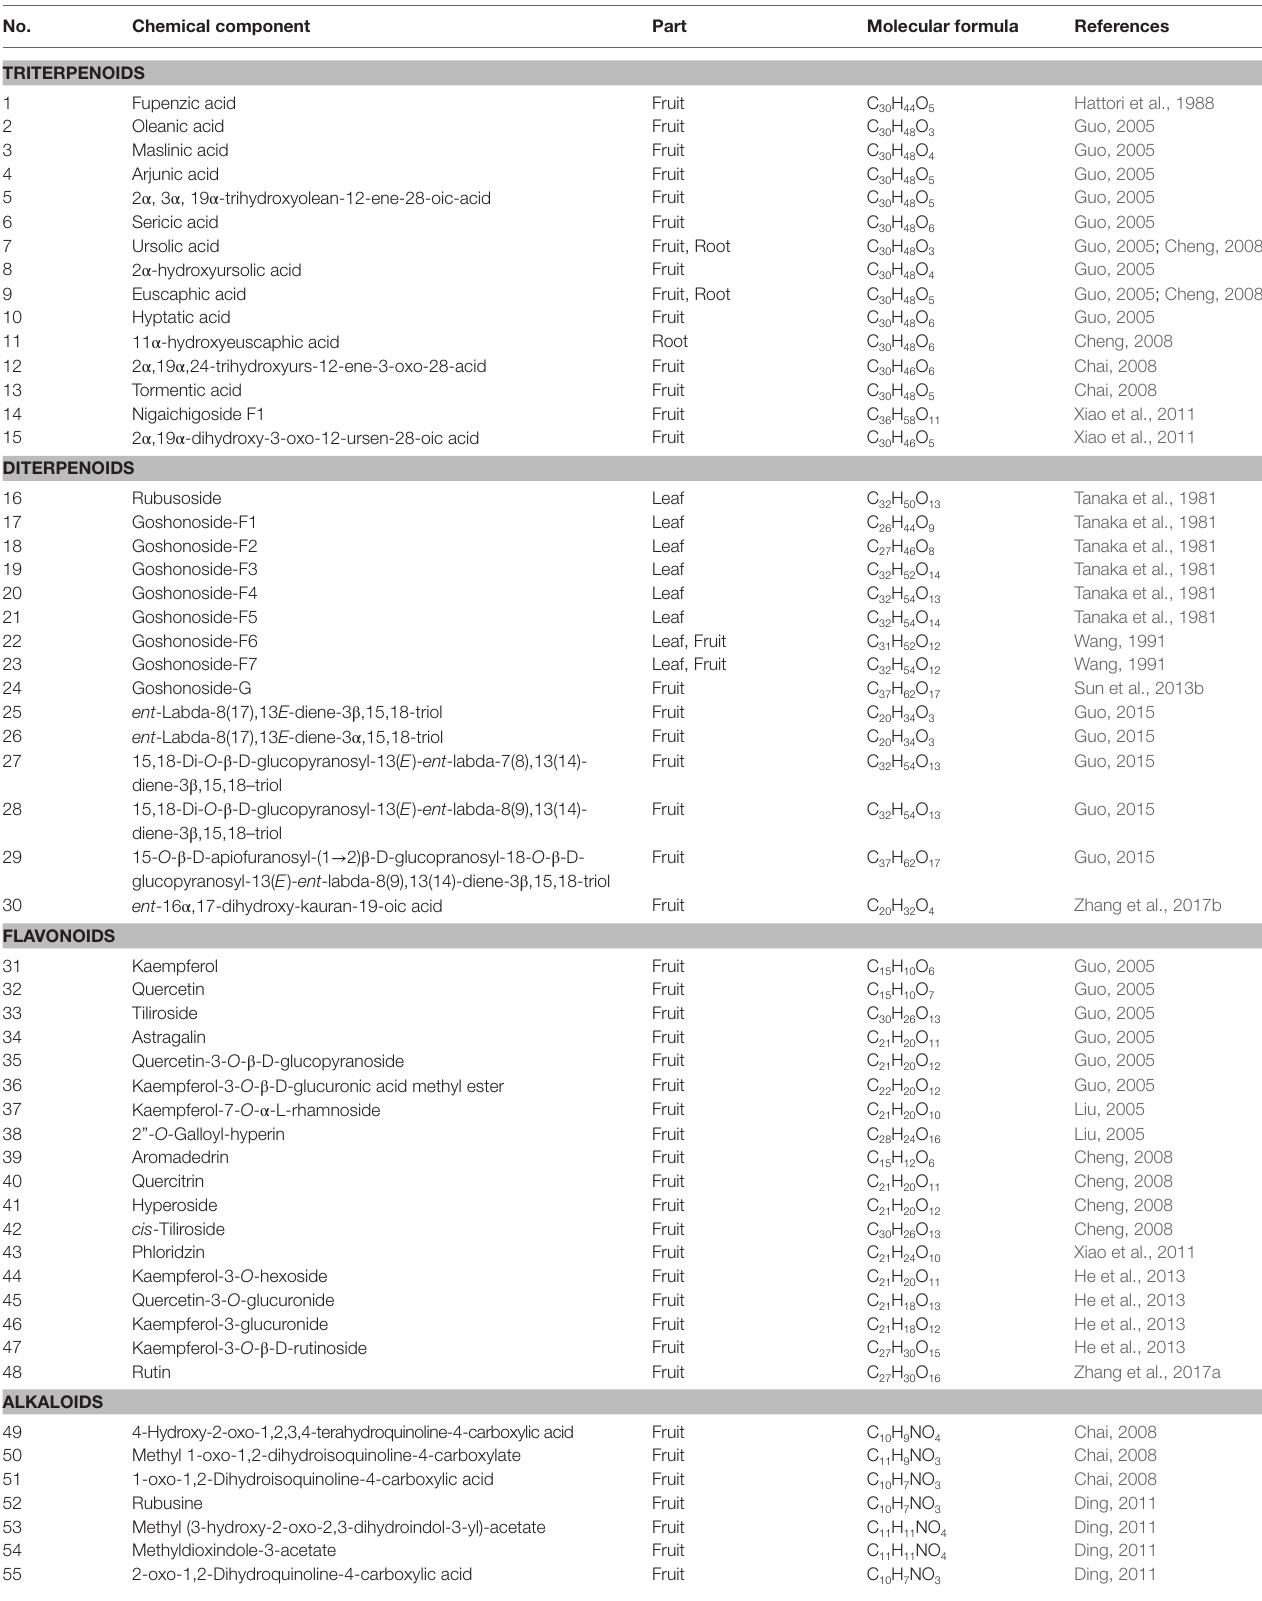
TABLE 1 | Chemical constituents of R. chingii